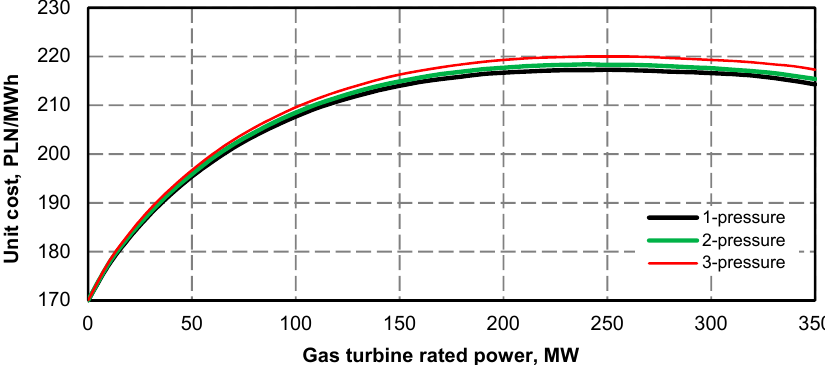
Figure 44. Unit generation cost for electric power as a function of gas turbine rated power for various structures of recovery boiler after increasing 10 times the emission rates for CO 2 , CO, SO 2 , NO x and dust ( e c = 10.0 PLN/GJ, e g = 27.7 PLN/MWh, (k el ) ex = 186.8 PLN/MWh).